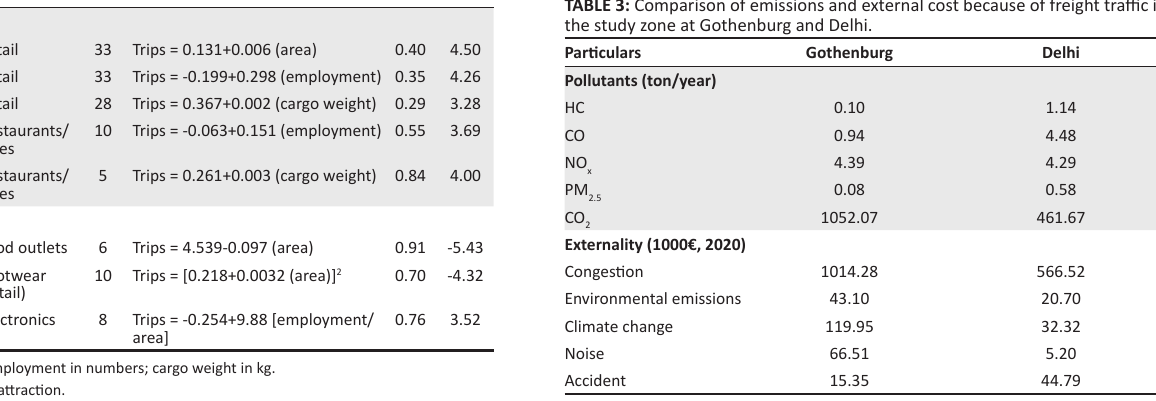
TABLE 2: Freight trip attraction models for different business activities in Gothenburg and Delhi. S.